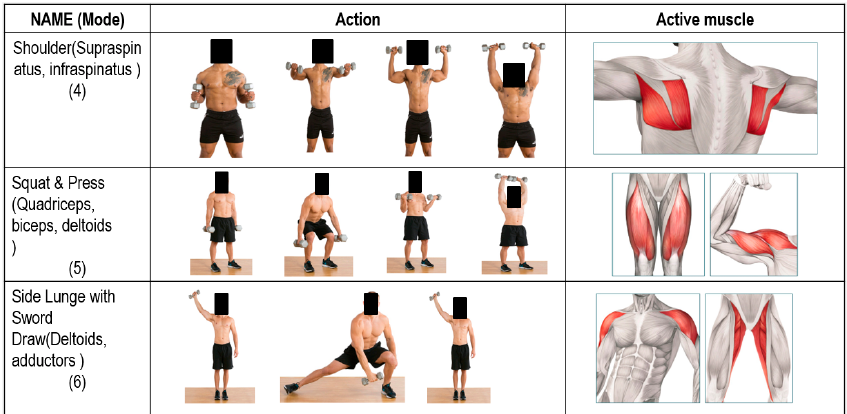
Figure 3. Three complex modes with groups of muscles in dumbbell train.